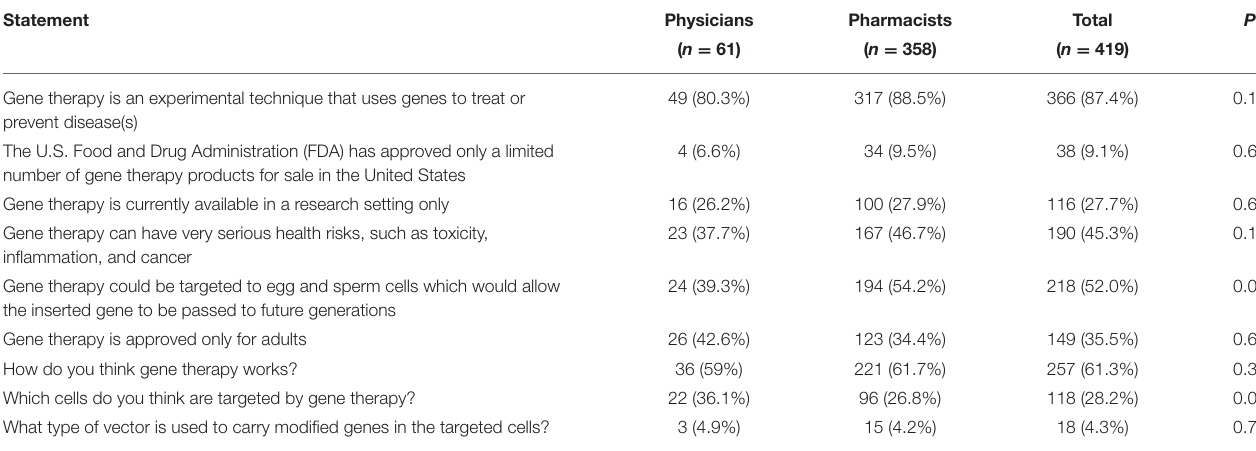
TABLE 2 | Information about the respondent’s knowledge of gene therapy.